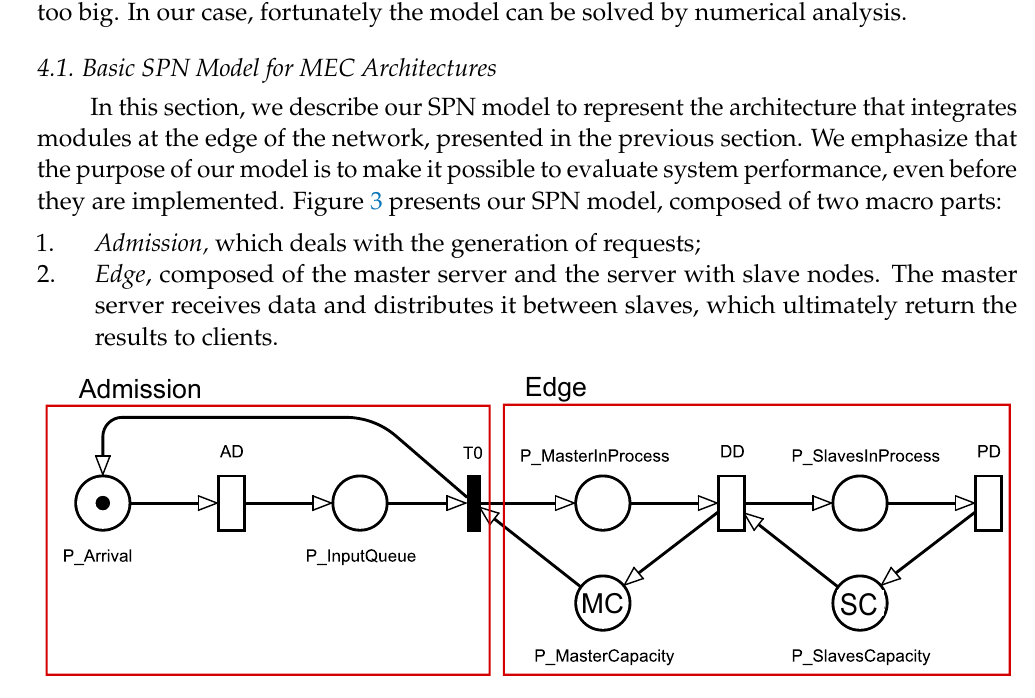
Figure 3. SPN Model for an Edge Computing